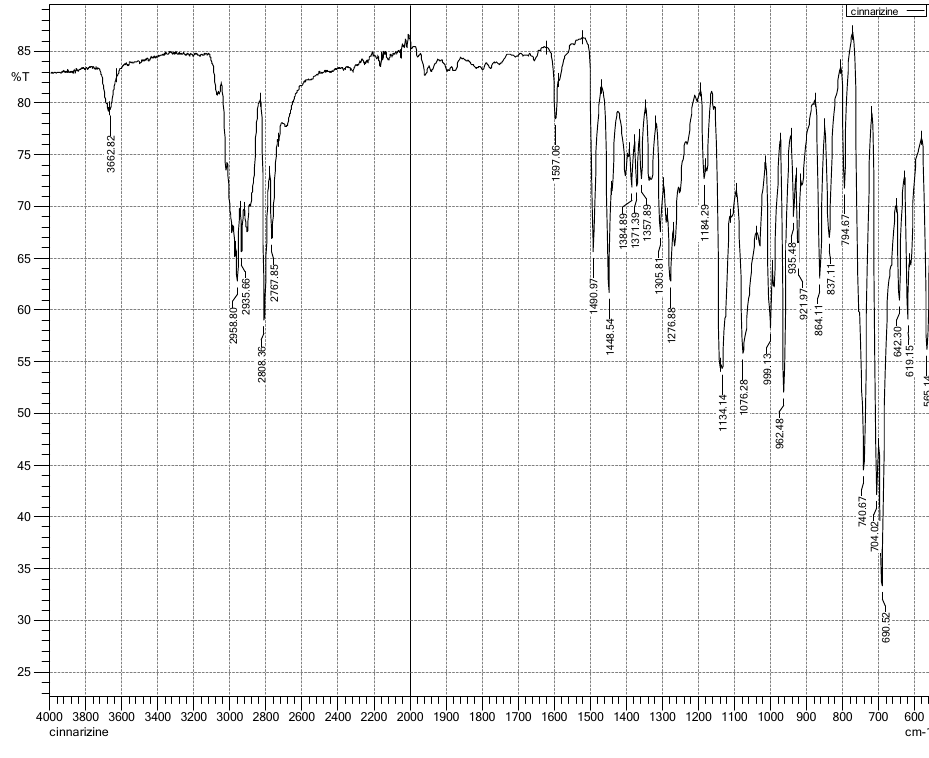
Figure 4. FTIR spectra taken for individual ingredient: cholesterol (green), Cremophor ® ELP (blue), Cremophor ® RH40 (purple), Solutol ® HS15 (black), and Span ® 60 (red).